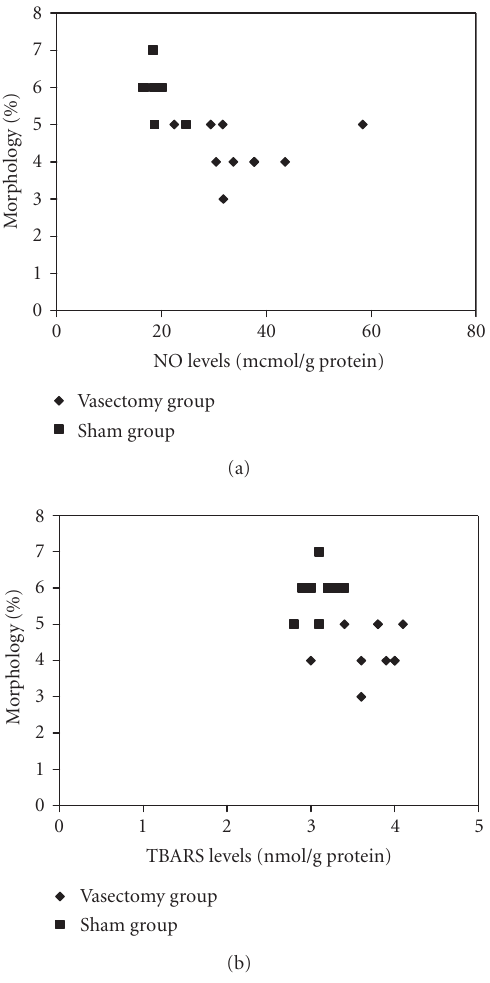
Figure 2: Correlation between sperm morphology and seminal plasma NO (a) and TBARS (b) levels in both groups.